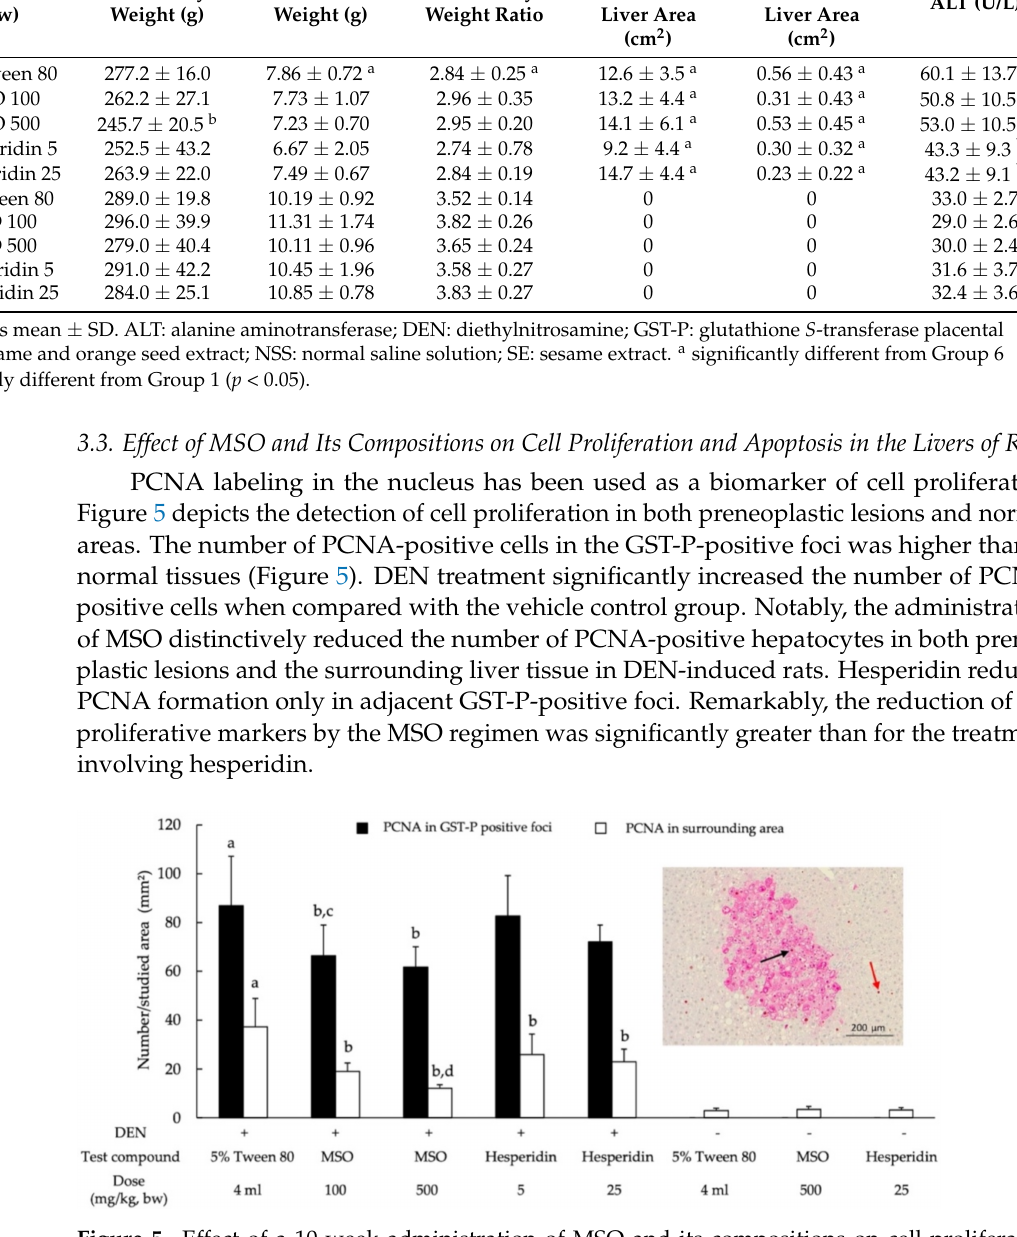
Figure 5. Effect of a 10-week administration of MSO and its compositions on cell proliferation in the livers of rat. Black arrow; PCNA-positive hepatocytes in GST-P-positive foci, red arrow; PCNA-positive hepatocytes in surrounding area. Values are expressed as mean ± SD. DEN: diethyl- nitrosamine; GST-P: glutathione S -transferase placental form; MSO: mixed sesame and orange seed extract; PCNA: proliferating cell nuclear antigen; a significantly different from a negative control group ( p < 0.05); b significantly different from a positive control group ( p < 0.05); c significantly different from group 6 (DEN + Hesperidin 5) ( p < 0.05); d significantly different from group 7 (DEN + Hesperidin 25) ( p <